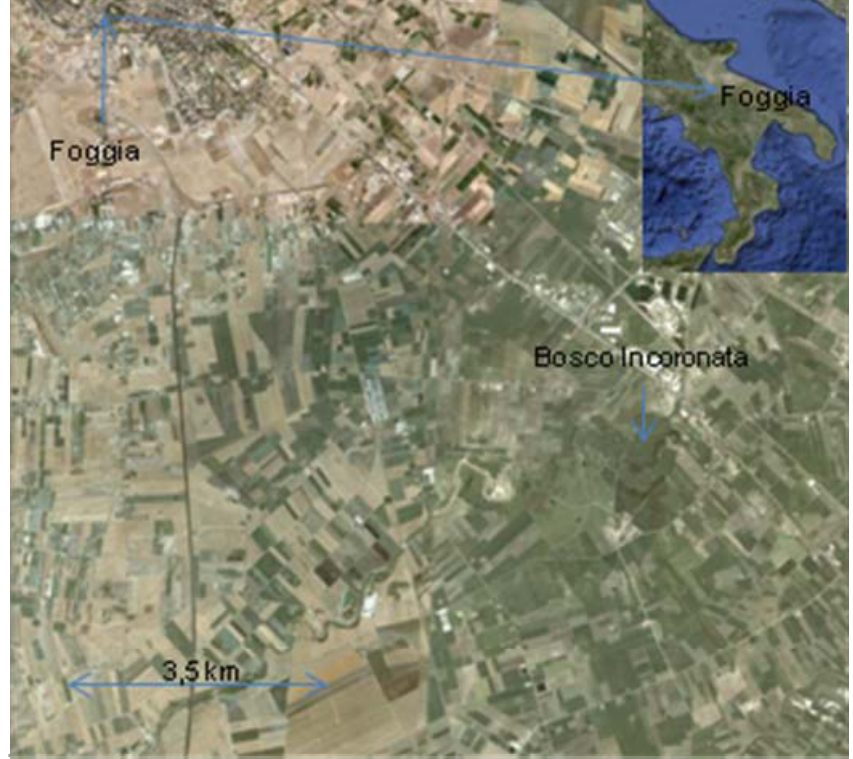
Fig. 3. Location of the study Figure 3 Location of the study area